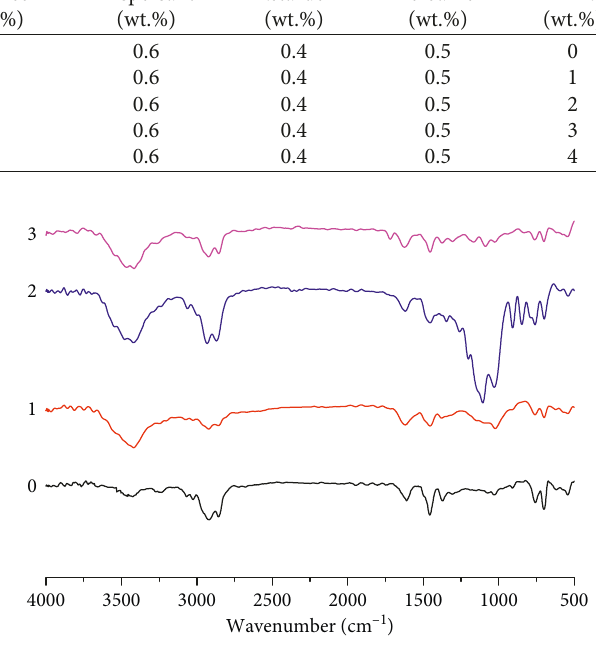
Figure 1: FT-IR spectra of TPR before and after modification (0: unmodified TPR; 1: TPR modified by KH550; 2: TPR modified by KH560; 3: TPR modified by